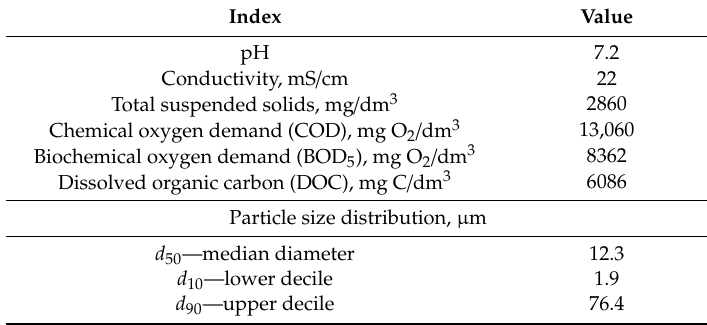
Table 1. The properties of the raw liquid digestate fraction from the municipal waste biogas